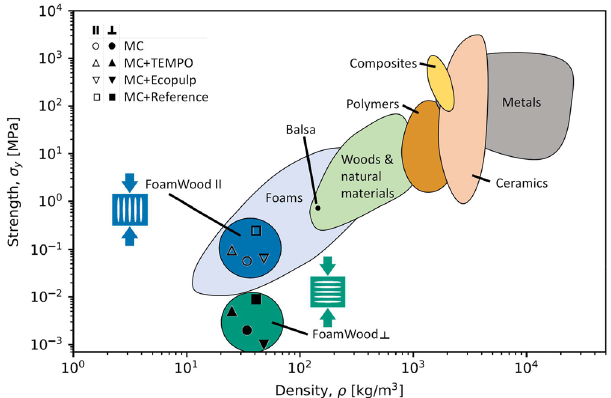
Figure 4. Material properties of wood-like solid foams: a comparison of the density vs. strength. An Ashby- type plot illustrating the relation of strength vs. density of FoamWood as well as other engineering materials. The colored areas are reproduced from Ref. 41